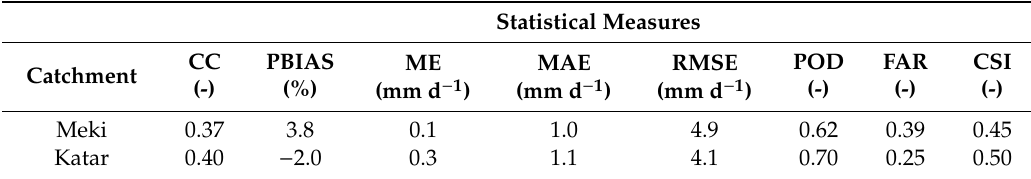
Table 4. Catchment scale daily average rainfall comparison from the rain gauge and the CHIRP satellite from 1985–2000.